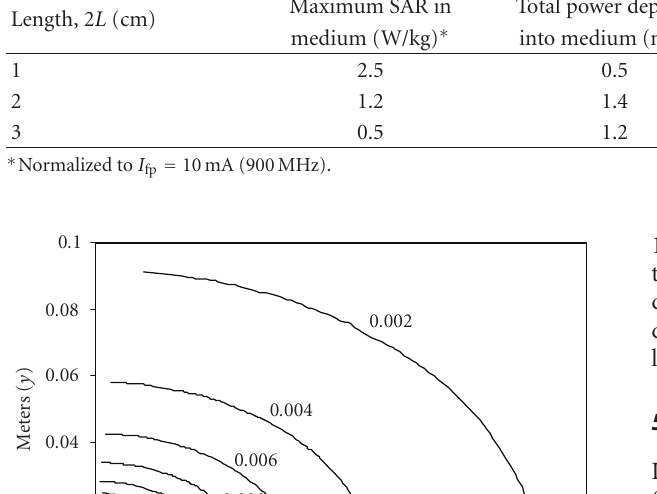
Table 1: Summary of temperature increases and absorbed power for short dipoles in a tissue-like dielectric medium. Length, 2 L (cm)